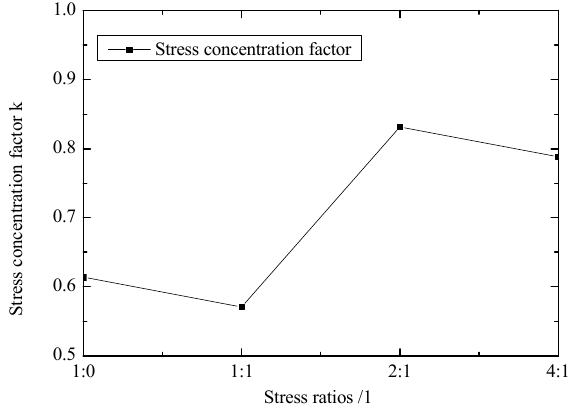
Figure 11. E ff ect of stress ratios on stress concentration factor. Figure 11. Effect of stress ratios on stress concentration factor.